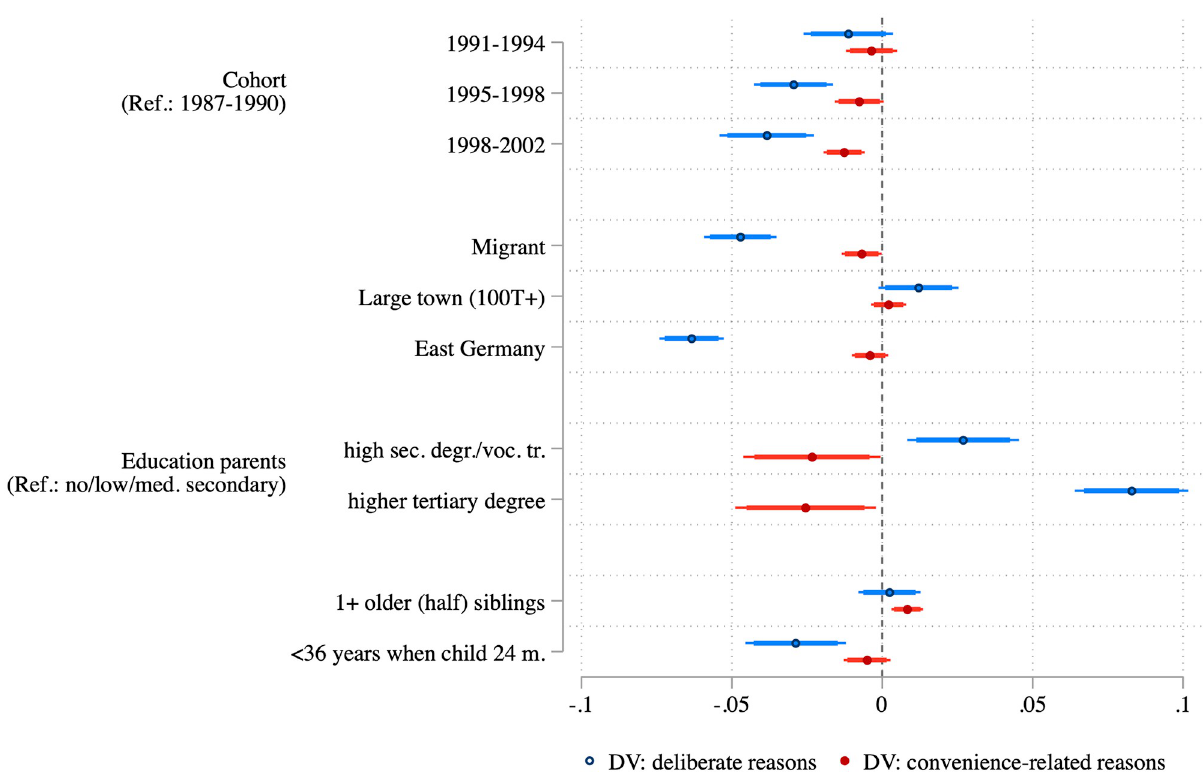
Fig 4. Average marginal effects from logistic regressions predicting deliberate and convenience-related reasons to not vaccinate. Point estimates, 95 percent confidence intervals (thin bars), and 90 percent confidence intervals (thick bars) showing average marginal effects based on multiply imputed weighted data (see S2